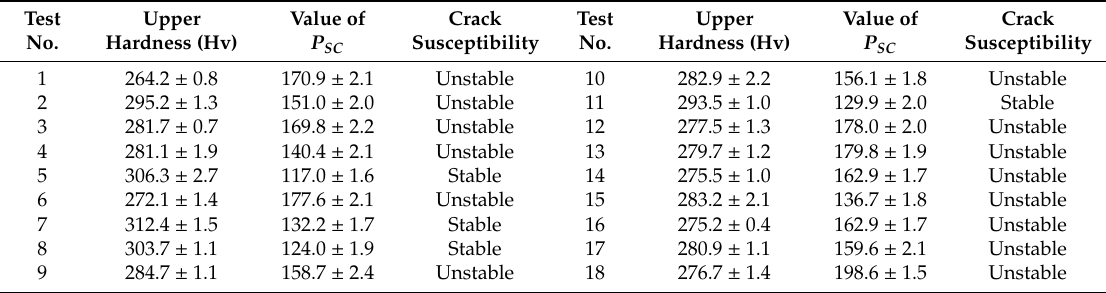
Table 8. Solidification crack susceptibility data for discriminant analysis in fiber laser welding. Test Upper Value of Crack Test P SC No. Hardness (Hv) Susceptibility